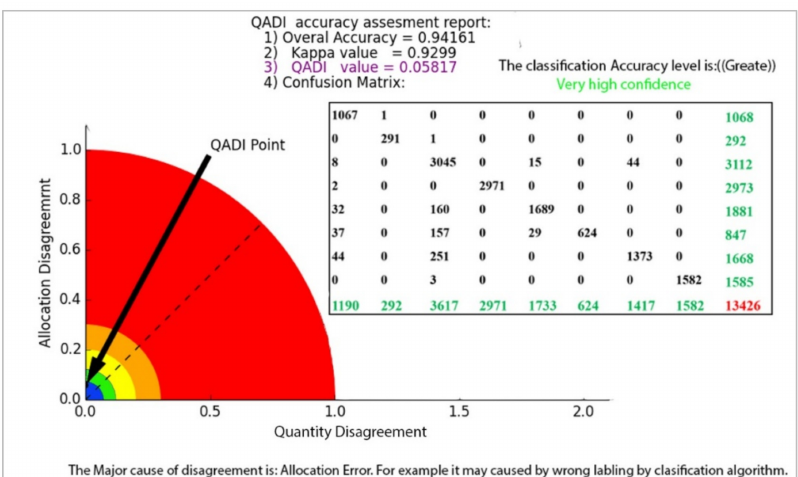
Figure 9. The QADI graph for the error matrix of LULC classification based on RF, (Table 8) developed by Leeuwen et al. [48].